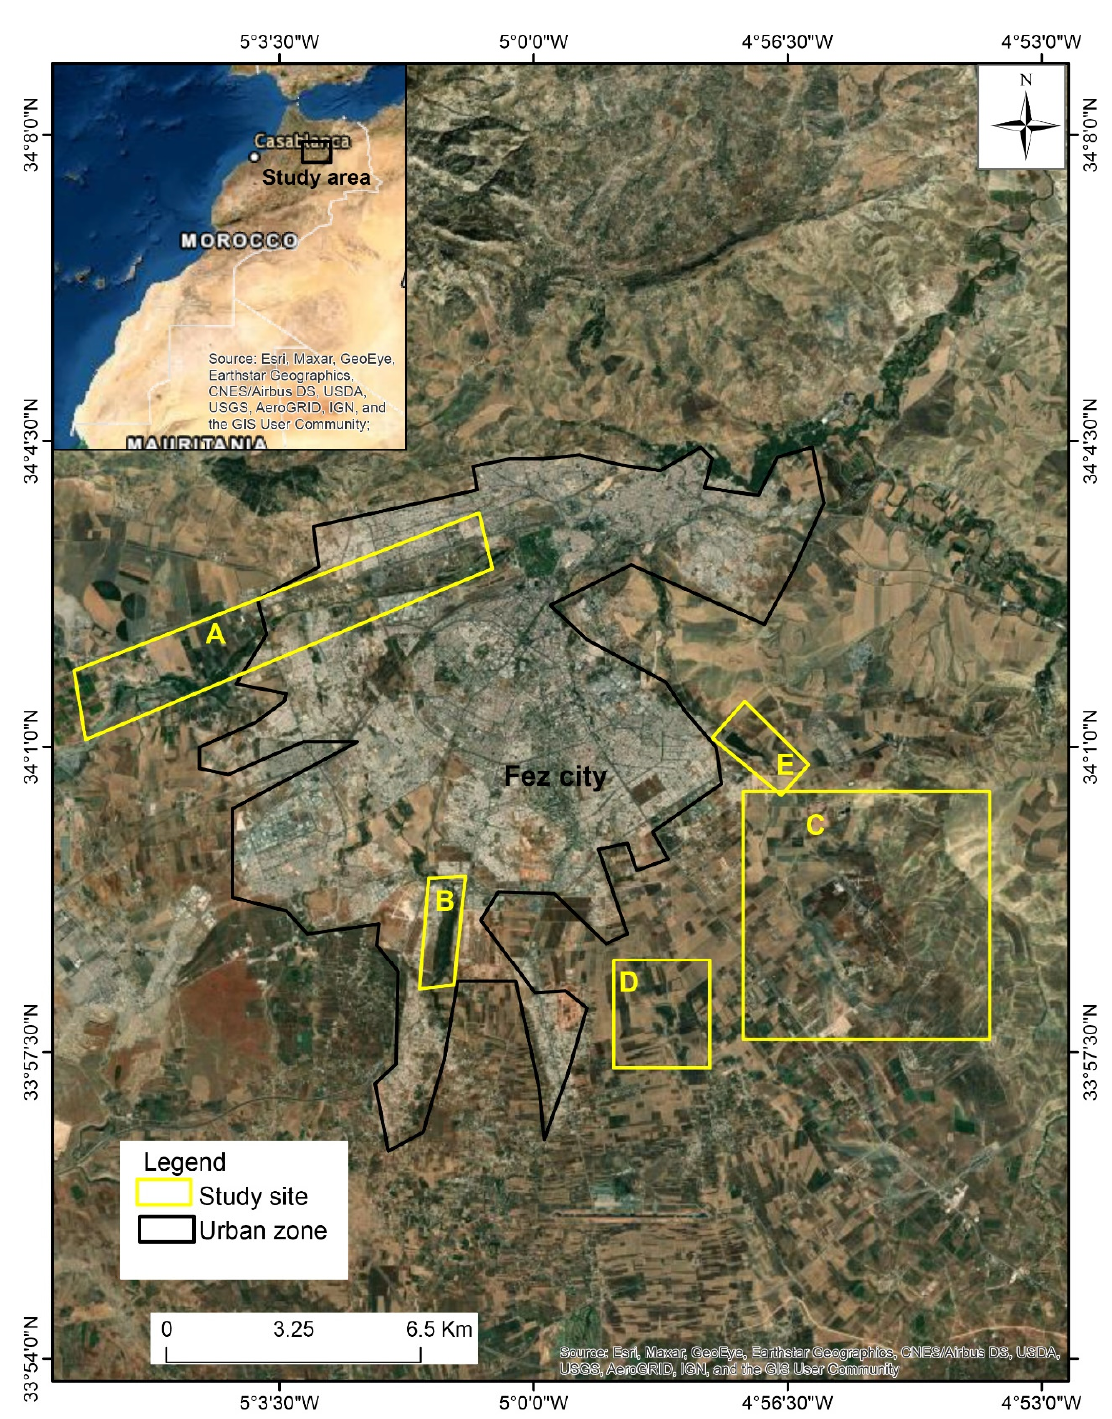
Figure 1. Location of Fez city and studied habitats (between 2018 and 2019). ( A ) Oued Fez river; ( B ) Ain Chkef Forest; ( C ) Ain Bida Dump; ( D ) El Mehraz Dam; ( E ) Gaada Dam.